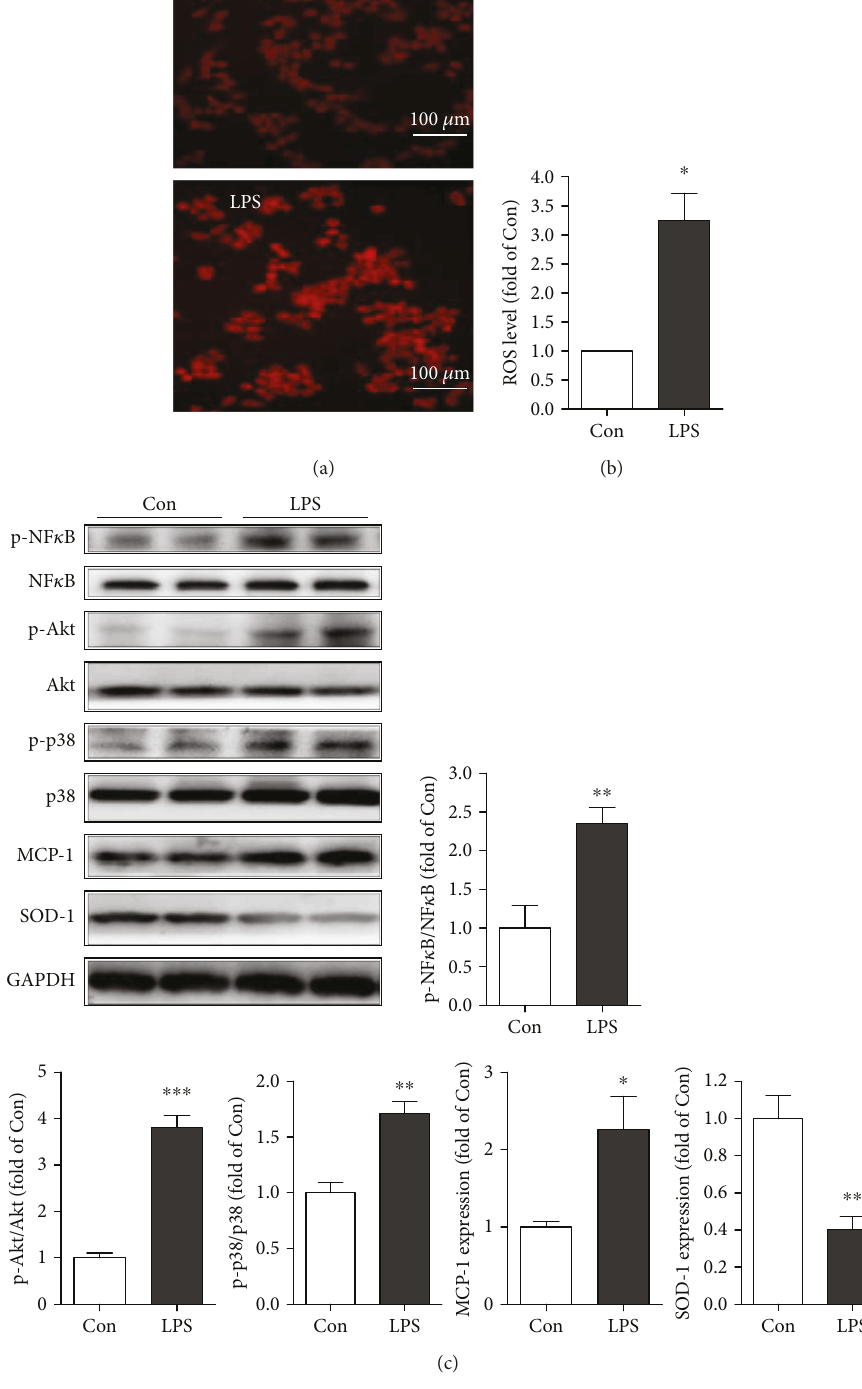
Figure 2: Oxidative stress-associated injury and the signaling pathways involved in LPS-induced in fl ammation of RAW264.7 cells. (a, b) DHE staining of the control and LPS pretreatment (1 μ g/ml) cells ( n = 4 , ∗ P < 0 05 versus control). (c) Western blot analysis of the p-Akt, Akt, p-p38MAPK, p38MAPK, p-NF- κ B, NF κ B, MCP-1, SOD-1, and GAPDH protein expression levels in the control and LPS- (1 μ g/ml) pretreated (for 24h) RAW254.7 cells ( n = 4 , ∗ P < 0 05 , ∗∗ P < 0 01 , ∗∗∗ P < 0 001 versus